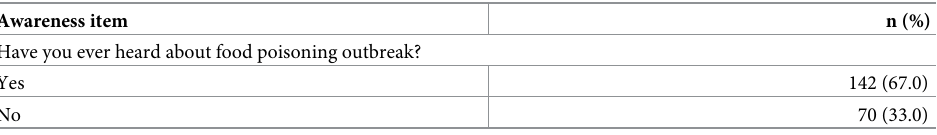
Table 2. Distribution of the respondents (%) according to the awareness of food poisoning outbreak (N = 212). Awareness item